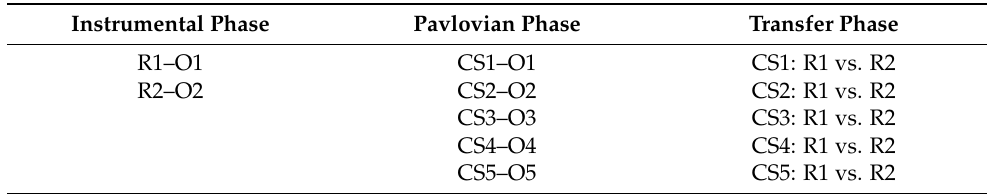
Table 1. Contingencies present in PIT